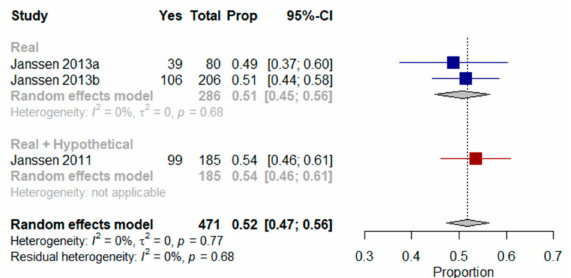
Figure 5. Forest plot comparing the preference for home as a place of end-of-life care: Shows results (%) from studies where the context was a real scenario or both scenarios.